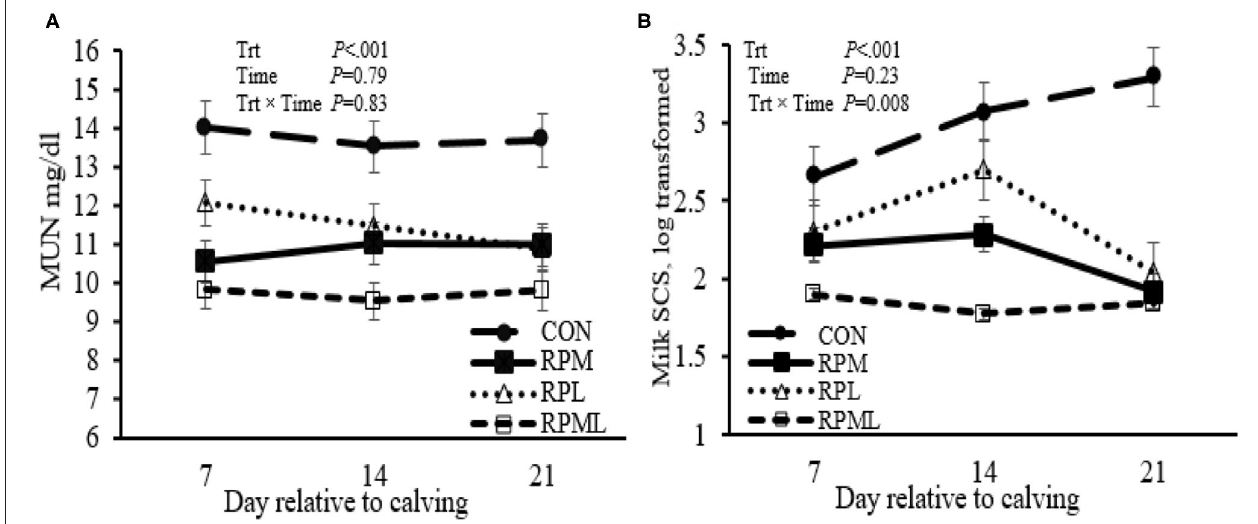
FIGURE 5 | Effect of ruminally protected Lys and Met supplementation on MUN and somatic cell count of Holstein dairy cows during the transition period. Values are means; standard errors are represented by vertical